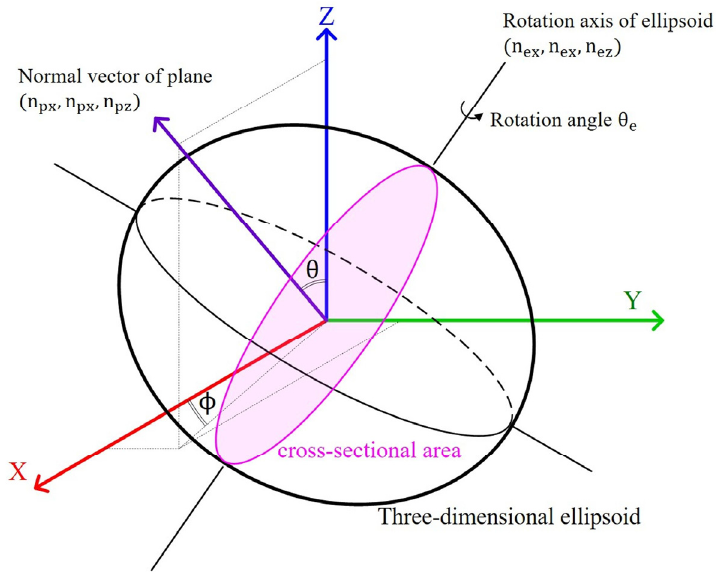
Figure 1. Schematic illustration of a three-dimensional ellipsoid with its center of gravity located at the origin.